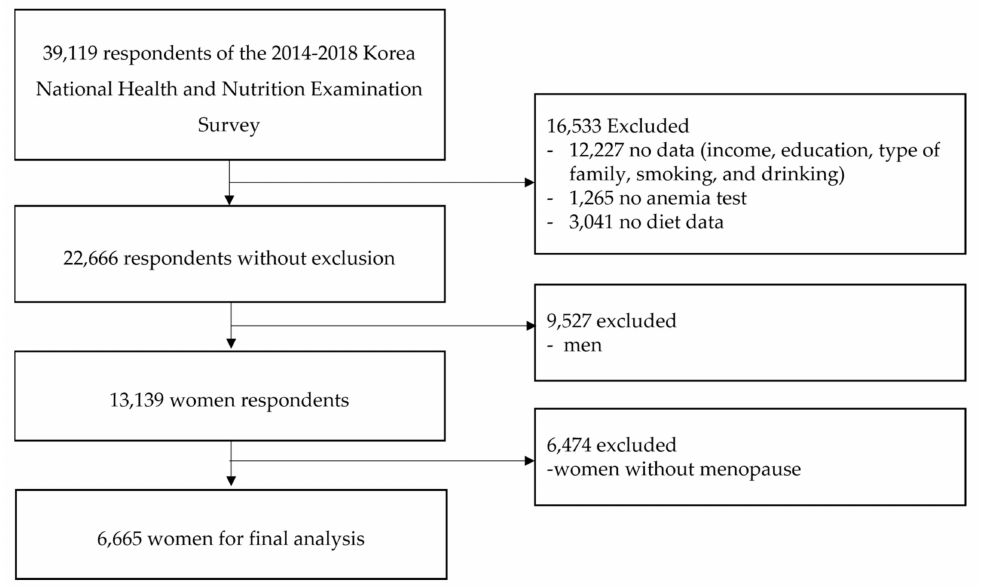
Figure 1. Selection of study